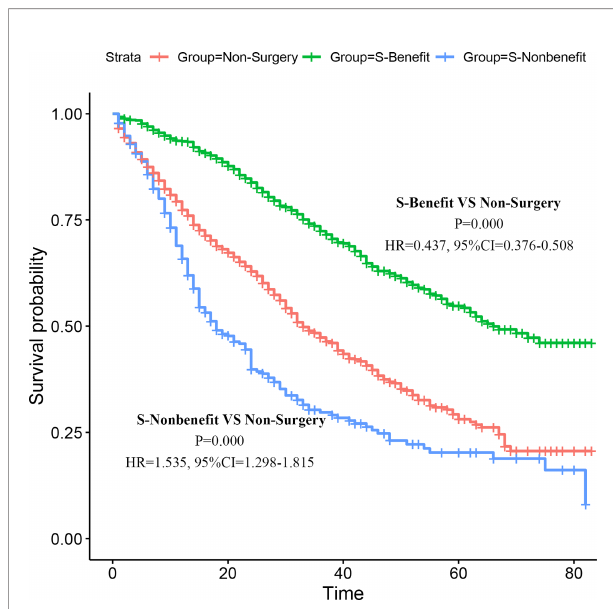
FIGURE 7 | Validation of the nomogram in the PSM cohort. Kaplan – Meier (K-M) survival analysis of the patients in the S-Bene fi t, S-Nonbene fi t, and Non-Surgery